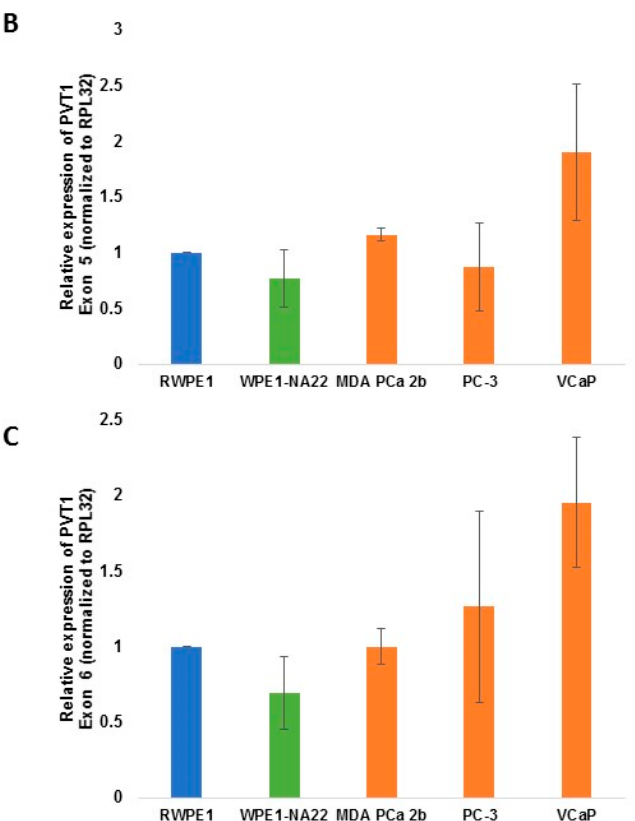
Figure 4. PVT1 exons 4b ( A ); 5 ( B ) and 6 ( C ) expression in non-tumorigenic and tumorigenic prostate epithelial cell lines. Four independent qPCR experiments were performed and every experiment was set up in quadruplicates. The data showed that there is no significant differential expression of the exons in the cell lines in comparing cell lines derived from CM with those derived from MoAA. The data are presented as mean + standard error of the mean (SEM).